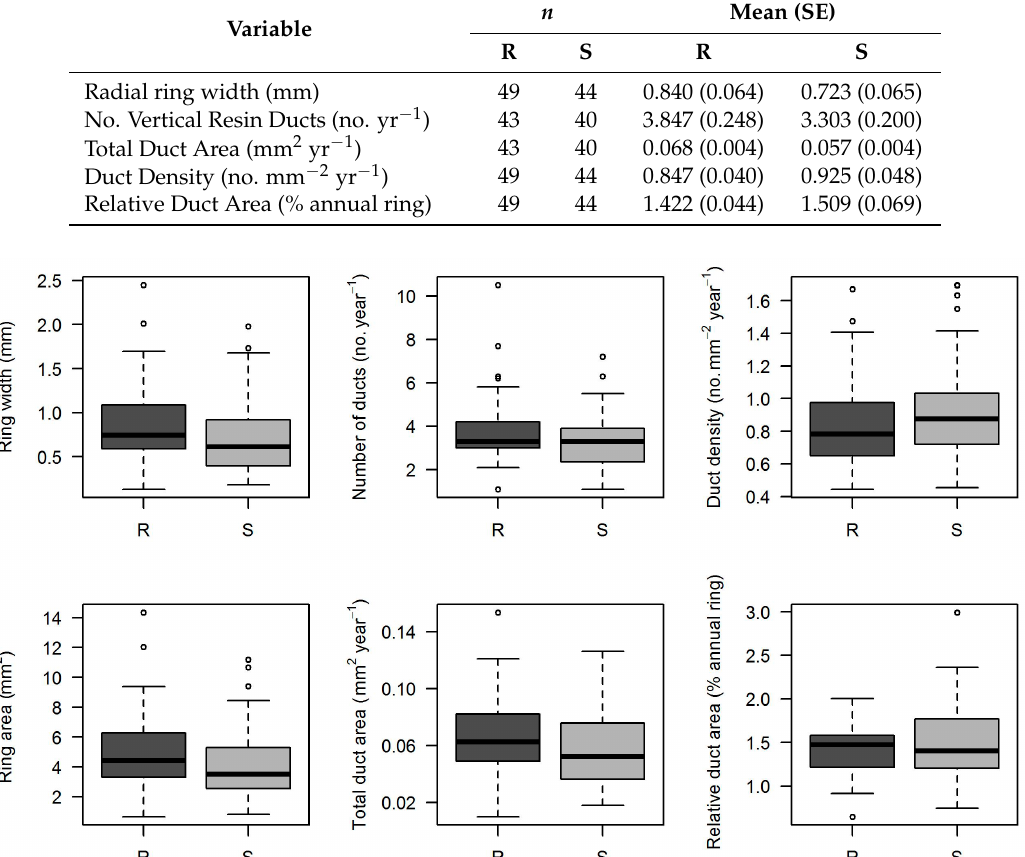
Table 2. Mean radial growth and resin duct metrics per year over a 10-year interval from 2001 to 2010 for R and S trees from the extracted limber pine cores. Means did not differ between R and S trees ( p > 0.05).